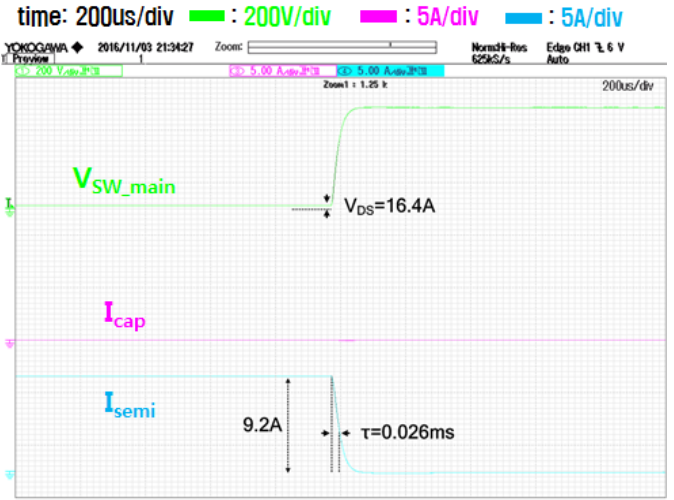
Figure 9. Experimental waveform of each part when the output state of Comparator 2 goes low.